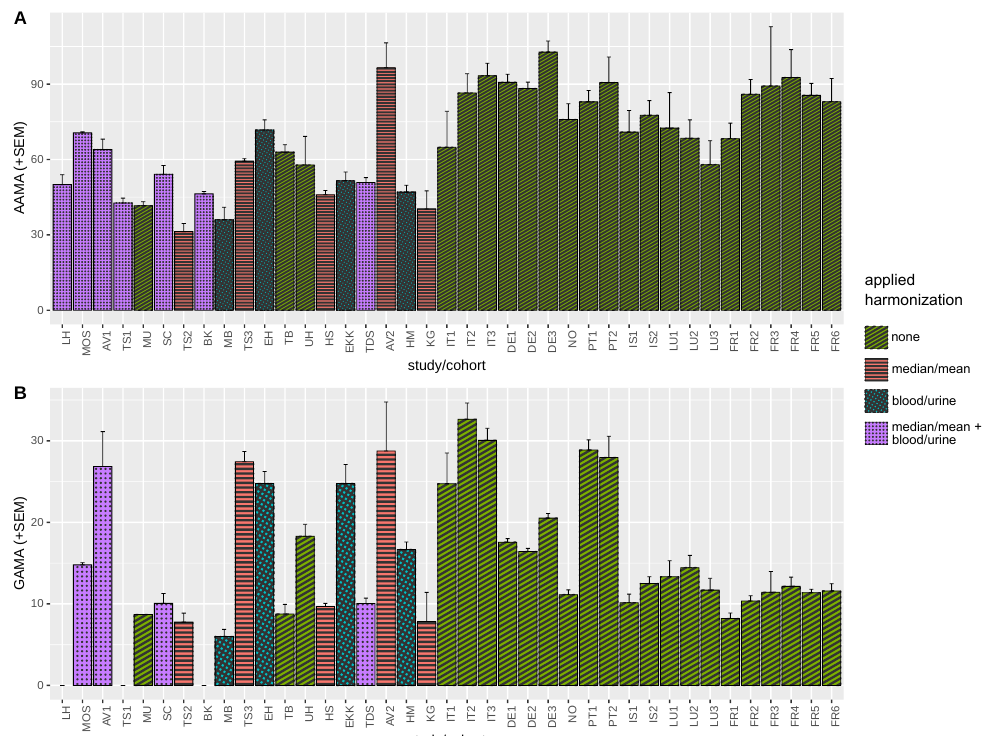
Figure 2. Harmonized overview of mean reported acrylamide biomonitoring levels based on pre- viously published literature and HBM4EU Aligned Studies (2000–2021). Mean/estimated mean (+standard error) for AAMA (µg/L, ( A )) and GAMA (µg/L, ( B )), color/pattern coded for applied harmonization calculation method. Standard error of the mean (SEM) is shown for visual comparison of variance taking into account of differences in study population size. Study index labels (LH-FR6) are shown according to Table